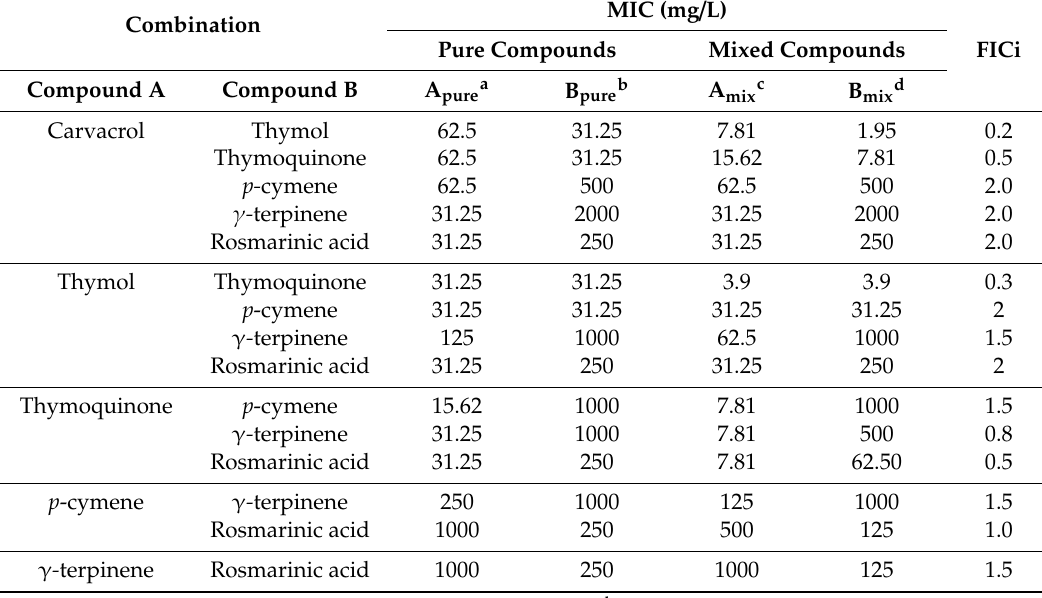
Table 2. Analysis of the synergistic activity of the six pure compounds tested as binary combinations (compound A + compound B) against Campylobacter jejuni 11168, in terms of the fractional inhibitory concentration index (FIC I ) calculated from the minimal inhibitory concentrations (MICs) of the pure compounds alone (A pure , B pure ) and when tested together (A mix , B mix ). See Equations (1)–(3) for further